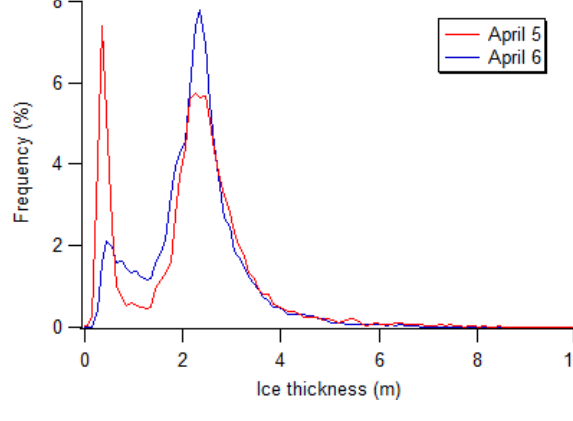
Figure 11. Ice thickness distributions obtained on 5 and 6 April during low-level flight segments only (time series are shown in Figure 10(a,b)). Modal thicknesses of new ice on refrozen leads and multi-year ice were 0.4 m and 2.3 m on 5 April, and 0.5 m and 2.4 m on 6 April 2009, respectively (bin width 0.1